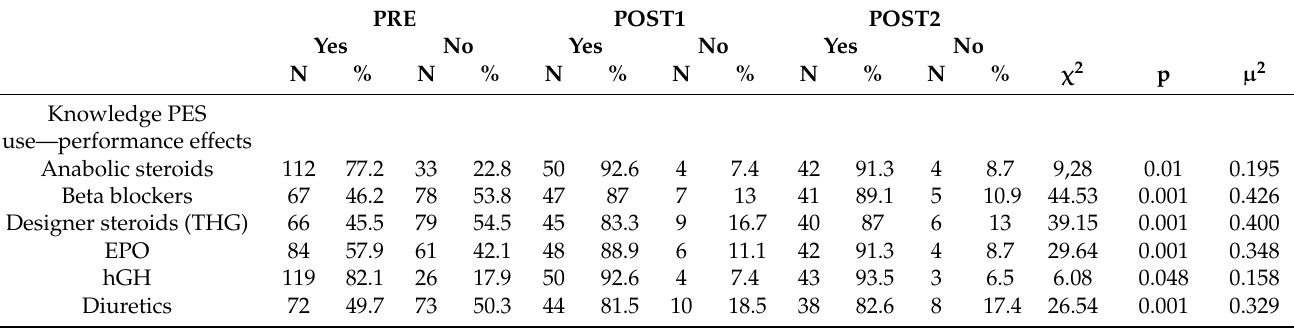
Figure 3. General ignorance about PES use on health in the long ‐ term. Table 2. Differences in PES use knowledge between three moments of educational